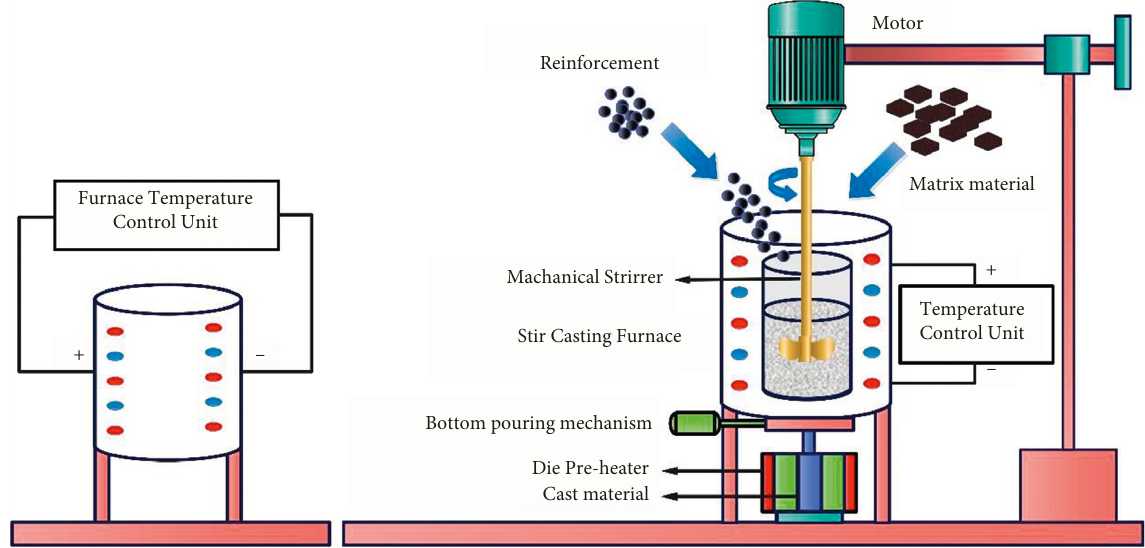
Figure 1: Schematic view of the stir-casting arrangement. Table 1: Stir-cast progression and hot-press progression